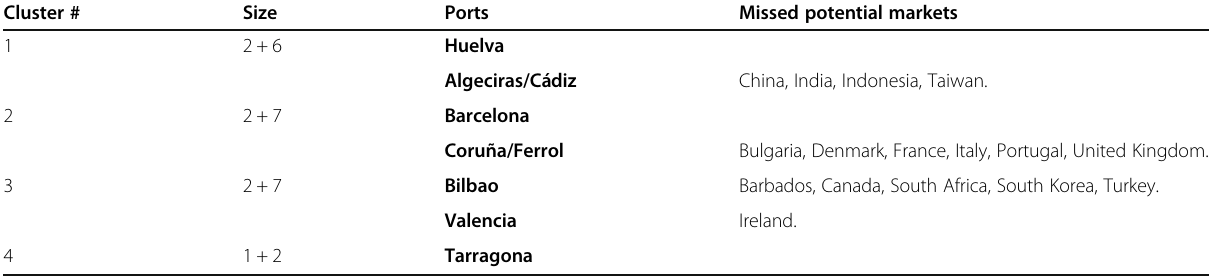
Table 7 Communities and link prediction for “ Biofuels ” import graph, in 2019. Size means number of ports + number of countries in the